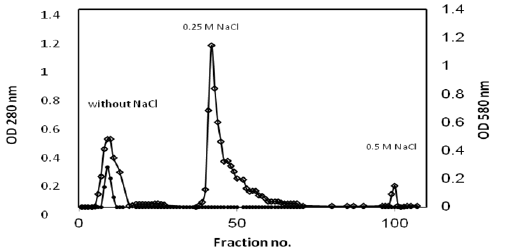
Fig. 3. Purification of AlgL with DEAE-Sepharose Cl-6B column chromatography. The protein was detected by measuring its absorbance at OD 280 (◊), and AlgL activity was detected with TBA-reactive material OD 548 (dotted line) after incubation for 20 min at 37°C.